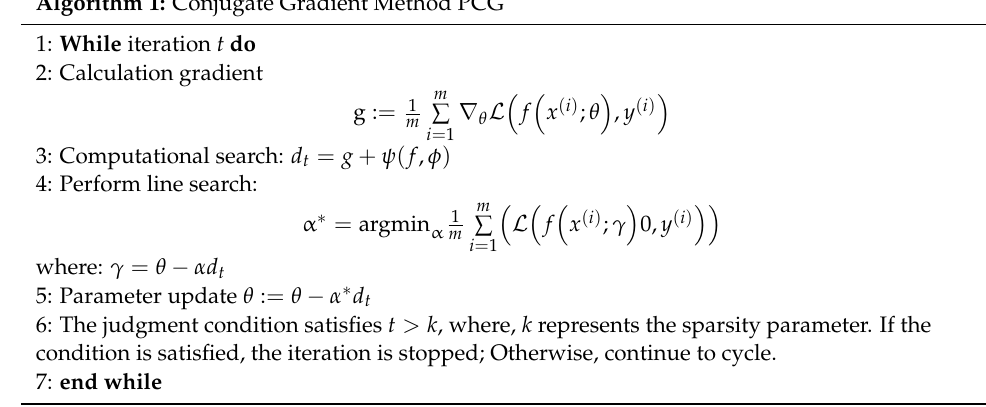
Algorithm 1: Conjugate Gradient Method